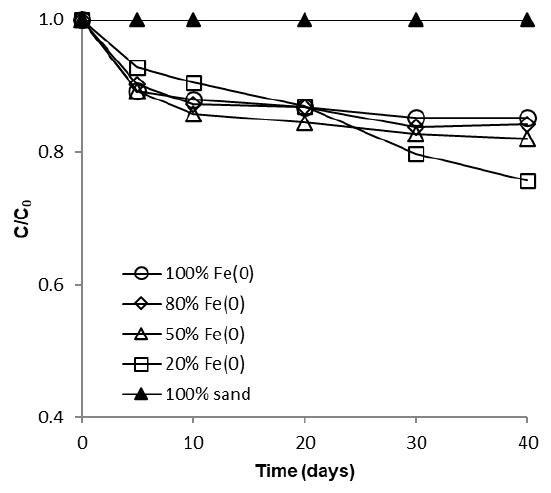
Figure 5. Time profile of Cr VI removal for batch experiments at high initial concentration.